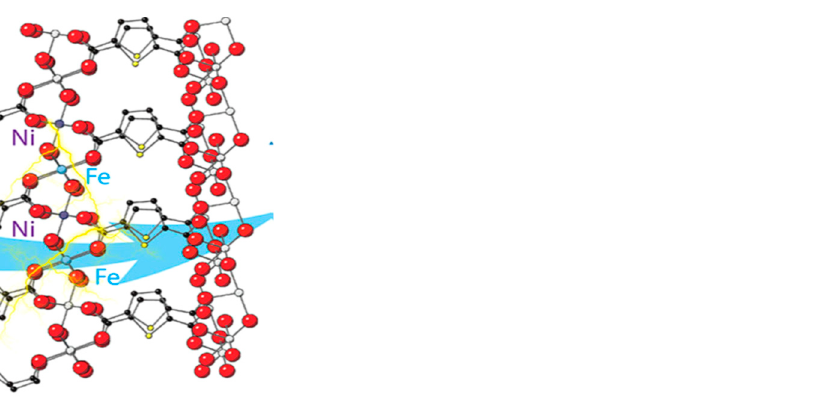
Figure 19. FeNi-MOF electrocatalyst for water oxidation. Reprinted with permission from (Wang CP et al., 2021) [166]. Copyright 2021 American Chemical Society.